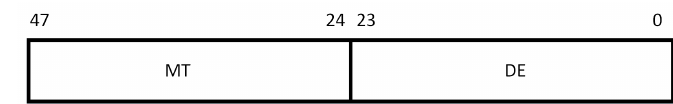
Figure 3. Individual